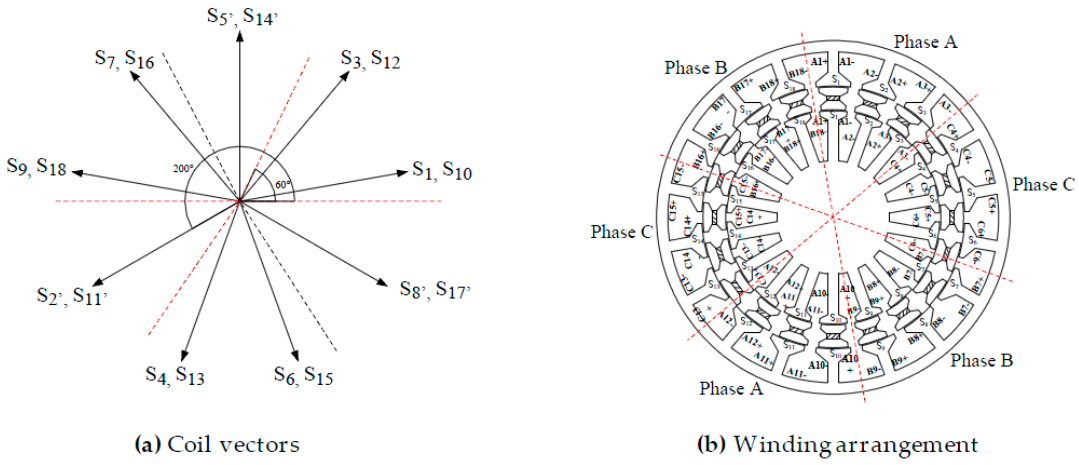
Figure 3. Coil vectors and winding arrangement of DSSR-PMG, ( a ) Coil vectors; ( b ) Winding arrangement. Table 2. DSSR-PMG coil arrangements.